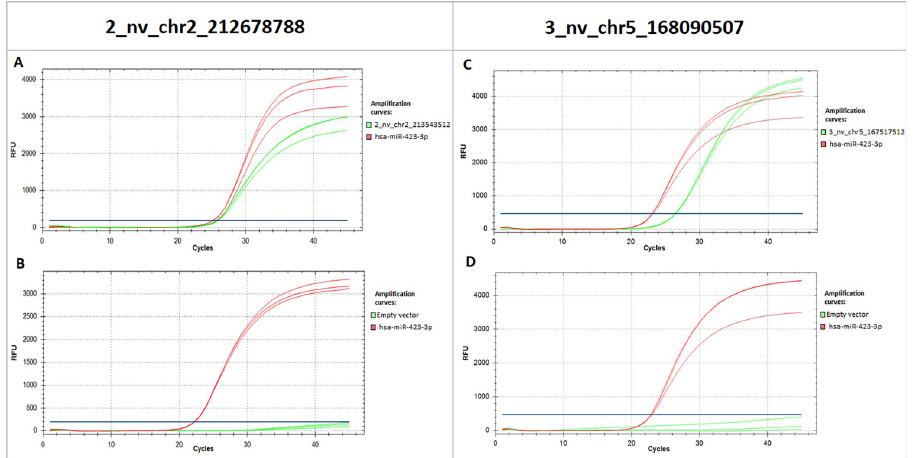
Fig 3. Expression of novel miRNAs in transfected HEK-293 cell line. RT-qPCR amplification curves showing expression of the mature sequences of novel miRNAs in the HEK-293 cell line transfected with the constructs containing the novel miRNA genes (upper panel) and empty vector (lower panel) respectively. Green curves represent expression of mature novel miRNAs A: of 2_nv_chr2_212678788 and B: of 3_nv_chr5_168090507. Red curves represent the expression of the reference